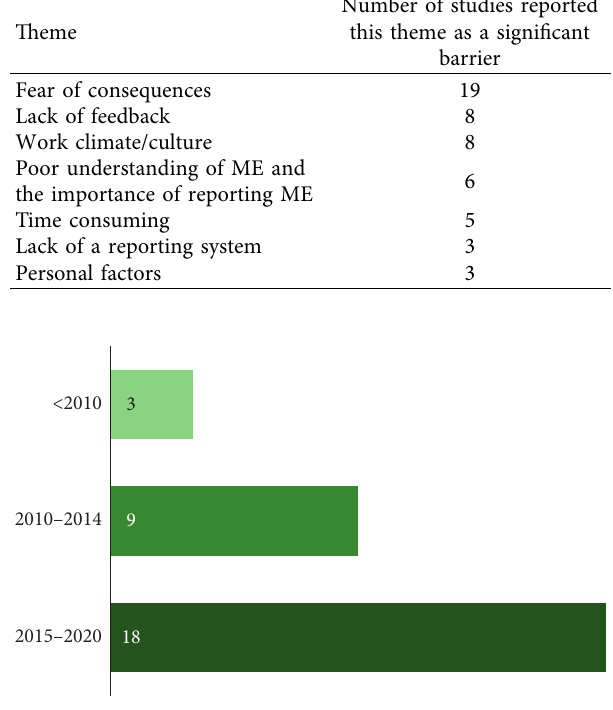
Figure 2: Year of publication of the selected